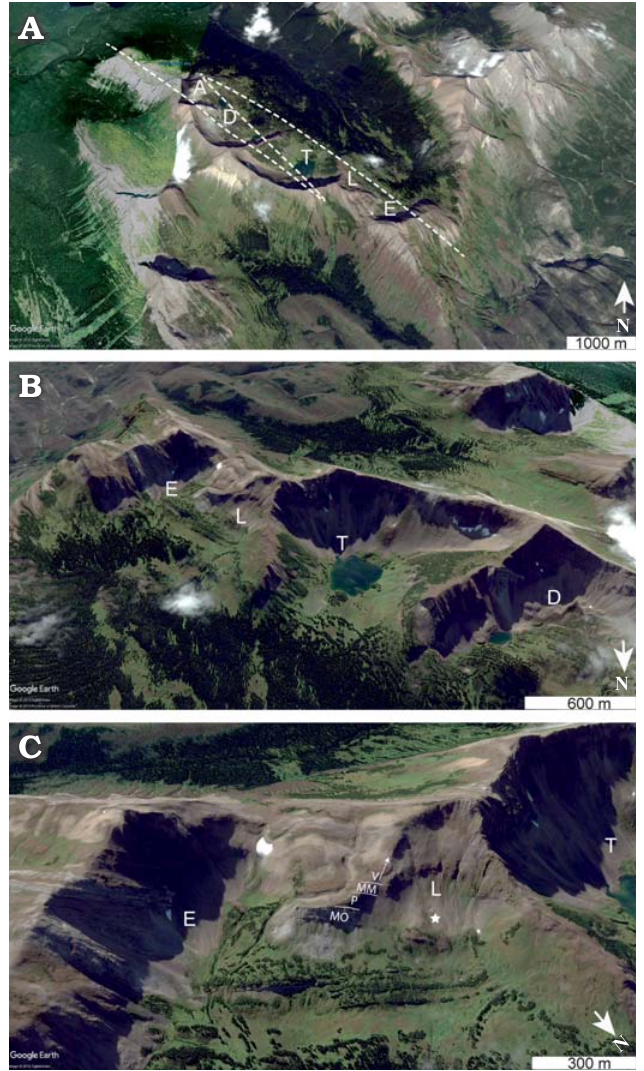
Fig. 1. 3D landscape images of Ganoid Ridge, Wapiti Lake area, British Columbia [downloaded from Google Earth Pro on October 3 rd 2018; im- agery Landsat/Copernicus (09/14/2011), ©2018 DigitalGlobe, ©2018 Pro- vince of British Columbia]. A . Overview of the complete Ganoid Ridge (reversed). White letters indicate different cirques at Ganoid Ridge. The stippled white line indicates the trend of the major anticline in the area (ad- opted from Mutter 2004: fig. 1a and references therein). B . Close-up of the southeastern cirques of Ganoid Ridge seen from the North. The anticline is well visible in the grey sediments of the Permian Mowitch Formation in the E and D cirques, surrounded by the darker brownish colored sedi- ments of the Sulphur Mountain Formation. C . Close-up of the fossil site (54°30’32” N; 120°41’24” W) indicated by the white star in the talus slop of the L cirque, seen from the Northeast. Note that well exposed layers in the E cirque can be traced into the L cirque, indicating a similar strati- graphic succession in both cirques. Abbreviations: MM, Meosin Mountain Member; MO, Mowitch Formation; P, Phroso Member, V, Vega